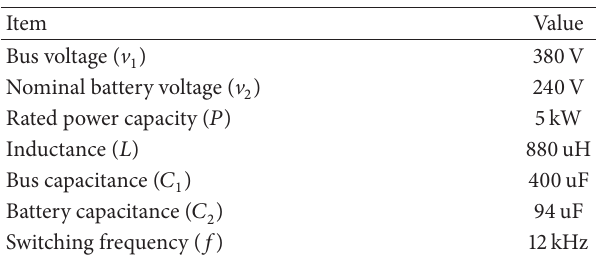
Table 1: Electrical